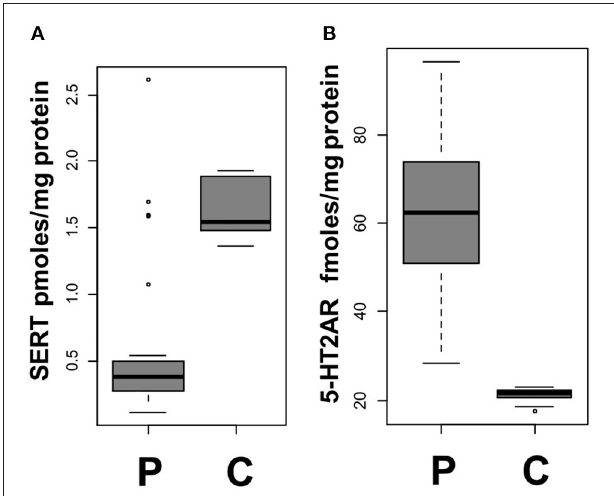
FIGURE 2 | Urinary markers at day 0. (A) Urinary 5-HT in patients (P) and controls (C) ( p = 0.011). (B) Urinary 5-HIAA in patients (P) and controls (C) ( p = 0.003). Each gray square indicates the IQR and the black line the